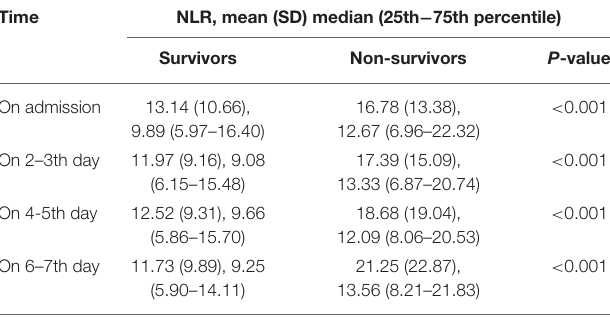
TABLE 3 | Multivariable logistic regression analysis of baseline NLR for mortality. Exposure Non-adjusted Adjust I Adjust II 30-day mortality OR 95% CI p -value OR 95% CI p -value OR 95% CI p -value